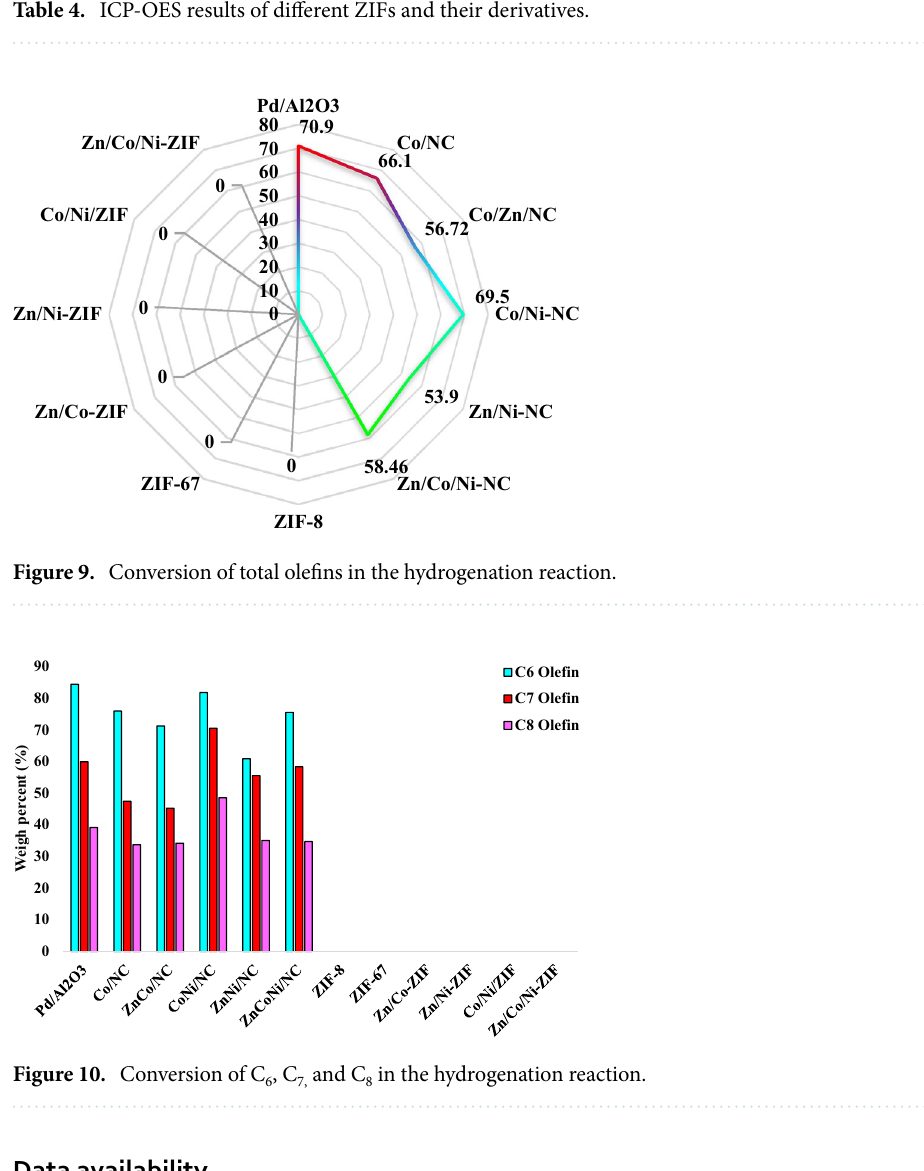
Table 4. ICP-OES results of different ZIFs and their derivatives.